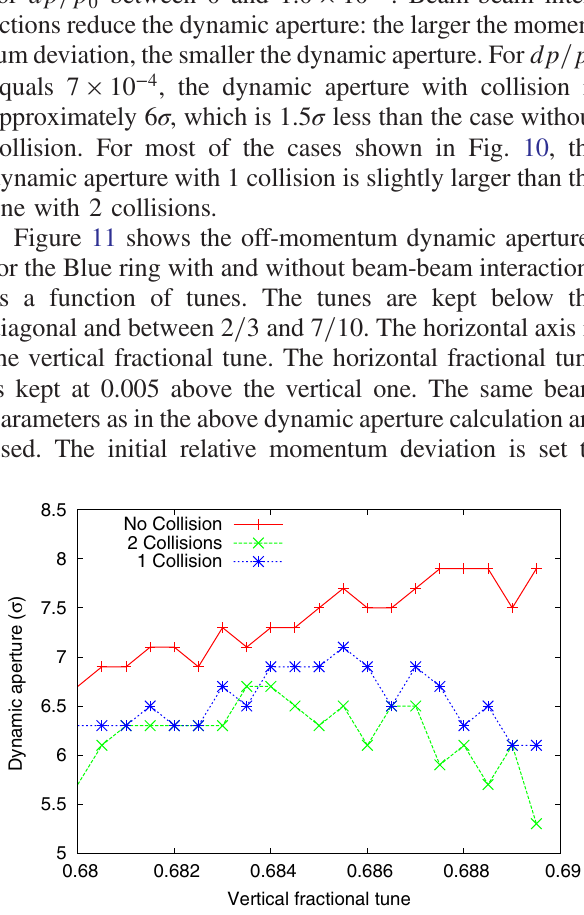
FIG. 10. Calculated off-momentum dynamic apertures without and with beam-beam interactions for the Blue ring. The particle energy is 255 GeV. for the Blue ring. Three cases are studied: without collision, with 2 collisions at IP6 and IP8, and with 1 collision at IP6. The dynamic aperture without collision stays around 7 . 5 σ for dp=p 0 between 0 and 1 . 0 × 10 − 3 . Beam-beam inter-